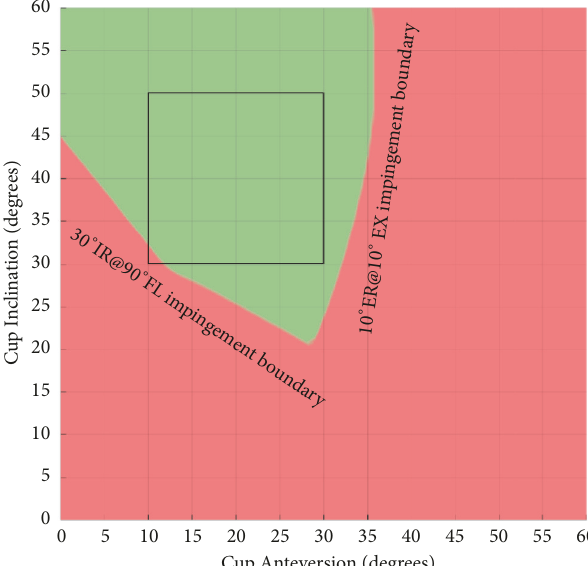
Figure 3: Impingement plot at 30 ∘ IR @ 90 ∘ FL and 10 ∘ ER @ 10 ∘ EX.